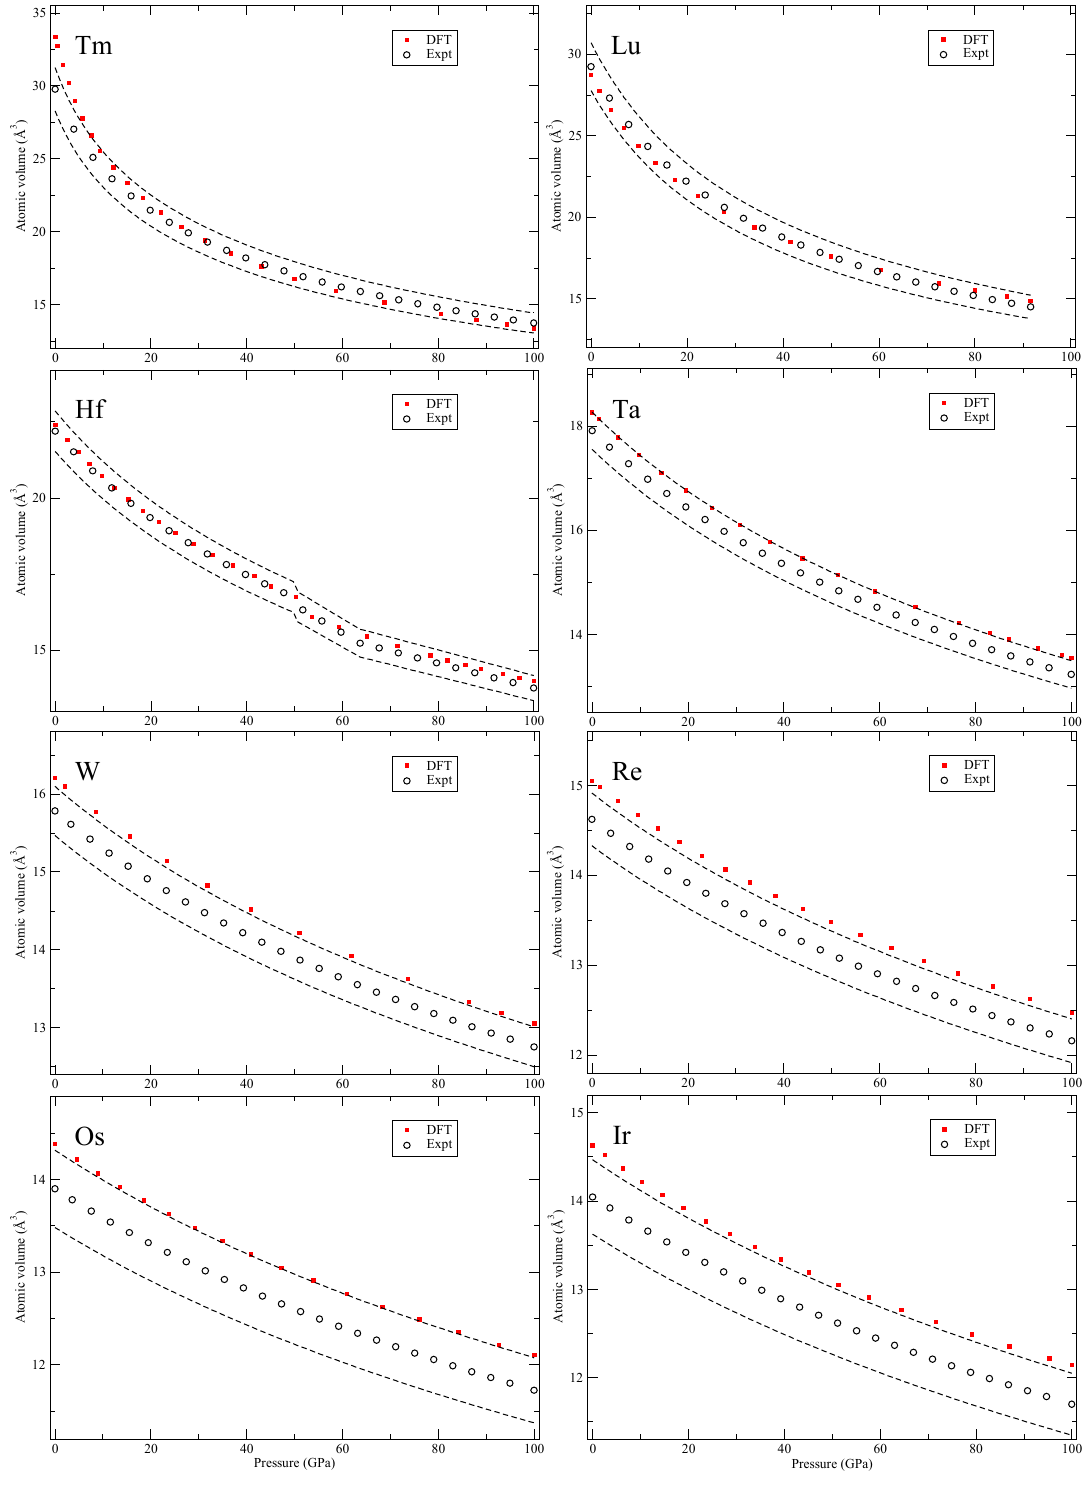
Figure 8. Experimental and DFT EOS for Tm, Lu, Hf, Ta, W, Re, Os and Ir.